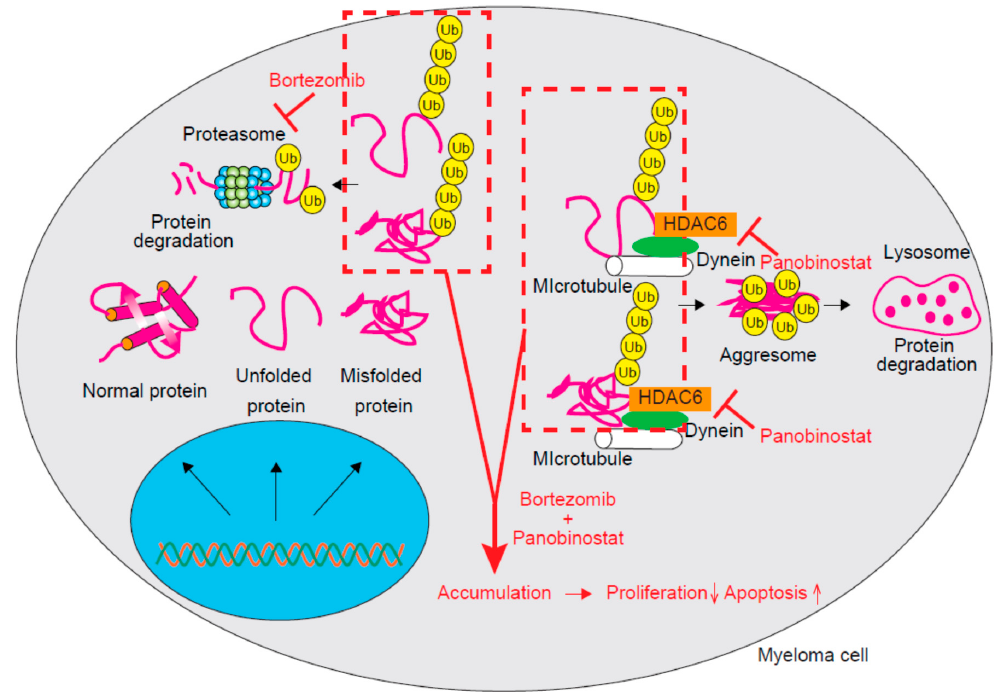
Figure 1. The molecular mechanism underlying the effect of combination therapy comprising bortezomib and panobinostat. Ubiquitinated unfolded/misfolded proteins are degraded by the proteasome. Those proteins escaping from proteasomal degradation will form aggresome complexes with dynein on microtubules and be degraded in the lysosome. The addition of panobinostat will inhibit HDAC6 and block aggresome formation. Accumulated unfolded/misfolded proteins will decrease the proliferation and increase the apoptosis of myeloma cells. Ub,